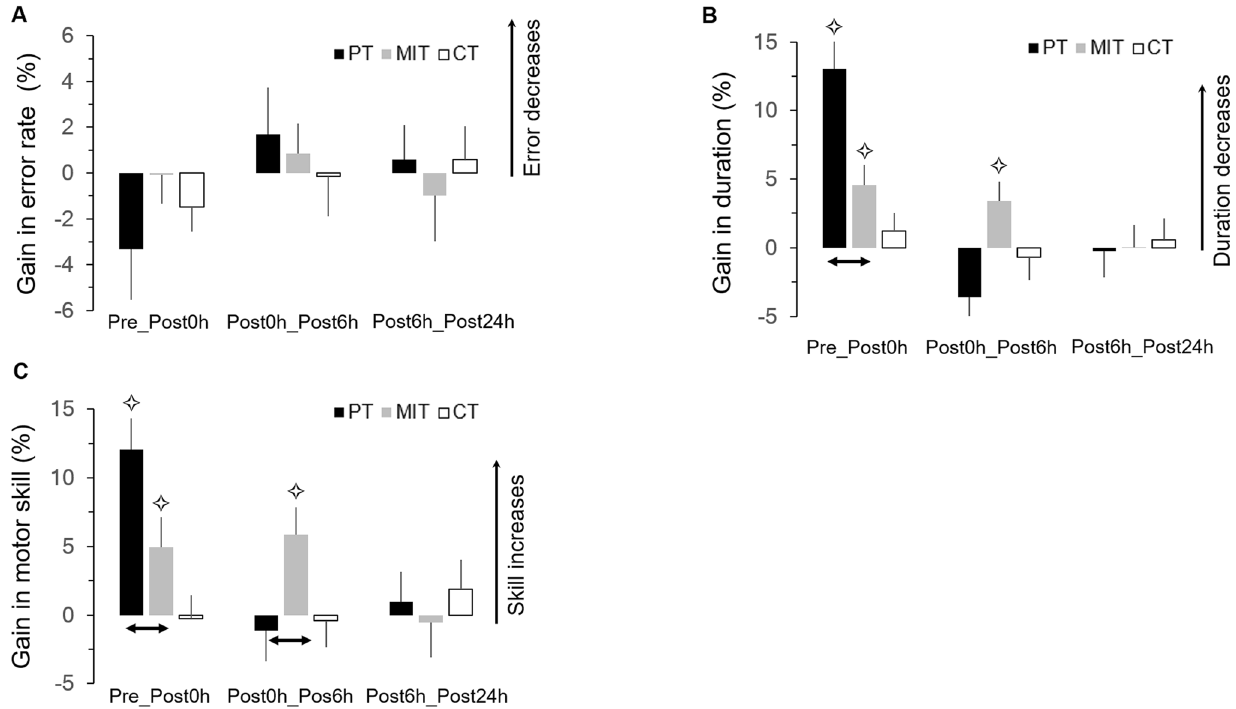
Figure 2. Average values (+ SE) of gains (%) in error rate ( A ), movement duration ( B ), and motor skill ( C ) between sessions for the three groups. Stars indicate significant differences from the value zero (0). Arrows indicate significant differences between groups. PT, Physical Training; MIT, Motor Imagery Training; C, control